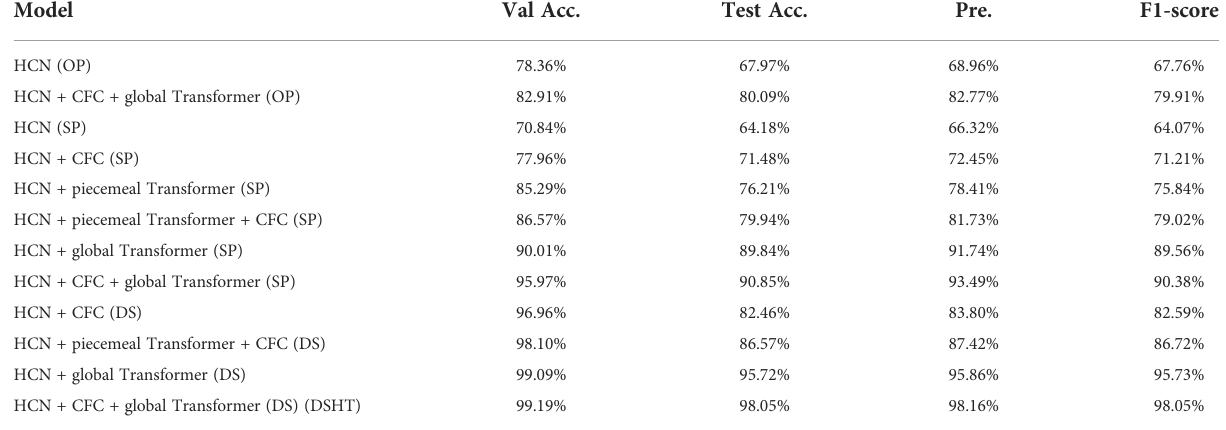
TABLE 3 The Grading Standards.